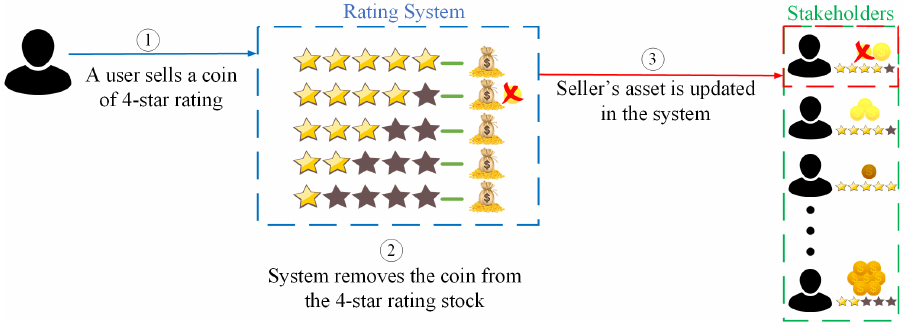
Figure 3. Selling a coin to the rating system. We used different colors to demonstrate the difference in coins of ratings’